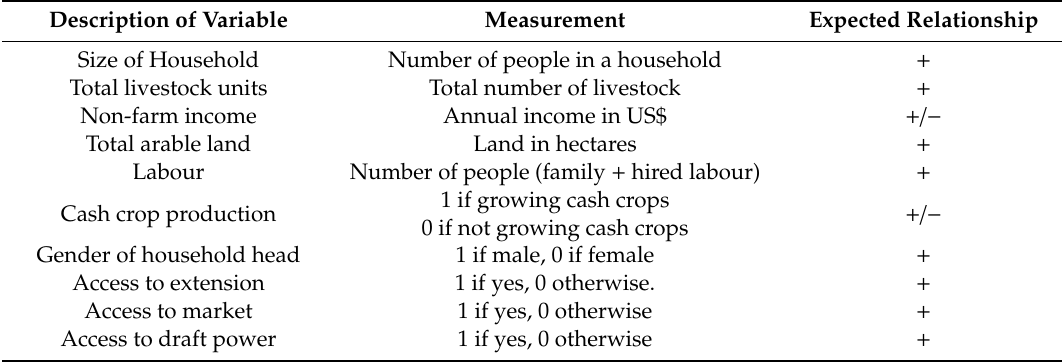
Table 1. Explanatory variables determining cash crop production contributions to food security.